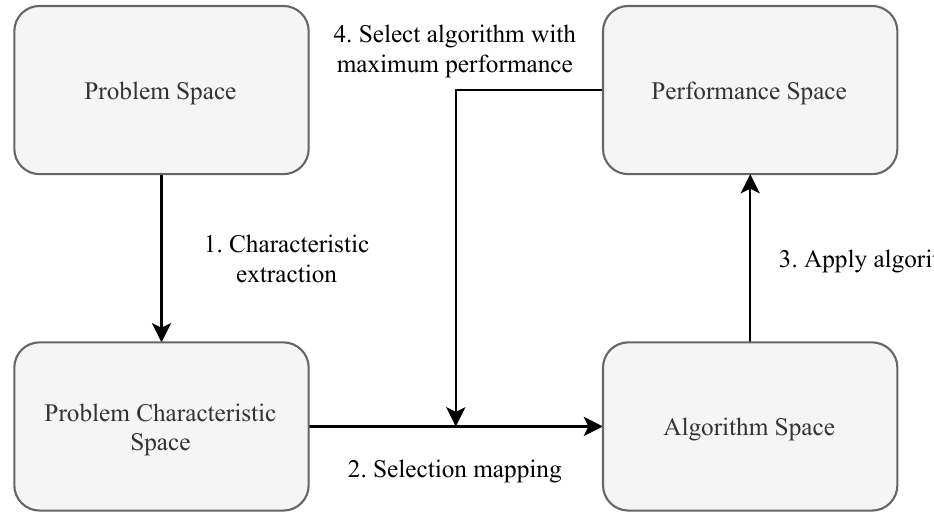
Figure 1. Illustration of the algorithm selection model component interactions